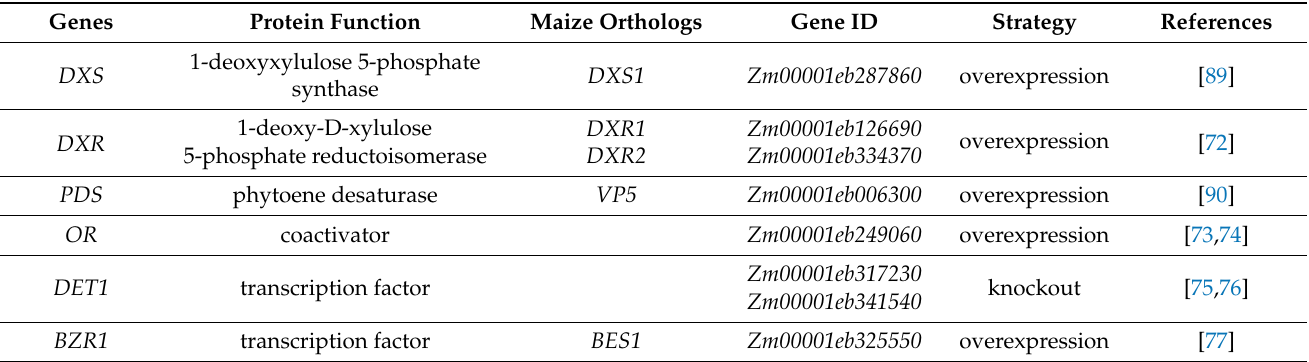
Figure 4. Schematic representation of vitamin biosynthetic pathways in plants. (G3P, glycerol-3- phosphate; DXS, 1-deoxy-D-xylulose 5-phosphate synthase; DXP, 1-deoxy-D-xylulose-5-phospate; DXR, 1-Deoxy-D-xylulose 5-phosphate reductoisomerase; IPP, isopentenyl diphosphate isomerase; PDS, phytoene desaturase; HPPD, ρ -hydroxyphenylpyruvate dioxygenase; HPT, homogentisate phytyltransferase; MPBQ, methylphytylbenzoquinol; HGGT, homogentisic acid geranylgeranyl transferase; TC, tocopherol cyclase; MPBQMT, 2-methyl-6-phytylbenzoquinol methyltransferase; DMPBQ, dimethylphytylbenzoquinone; PEP, phosphoenolpyruvate; E4P, erythrose 4-phosphate; ADCS, aminodeoxychorismate synthase; p-ABA, para-aminobenzoate; DHP, dihydropteroate; GTPCHI, GTP cyclohydrolase I; DHFS, dihydrofolate synthetase; DHF, dihydrofolate; THF, tetrahydrofolate; FPGS, folylpolyglutamate synthase; G6P, glucose-6-phosphate; GME, GDP-mannose 3,5-epimerase; GGP, GDP-L-galactose phosphorylase; GPP, L-galactose-1-phosphate; GDH, L-galactose dehydrogenase; GalLDH, L-galactono-1,4-lactone dehydrogenase). Table 4. List of potential gene resources for enhancing vitamin contents in maize.